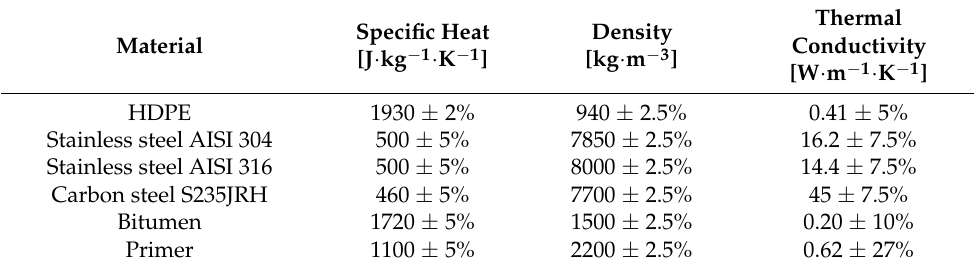
Table 4. Thermophysical properties of the specimens.